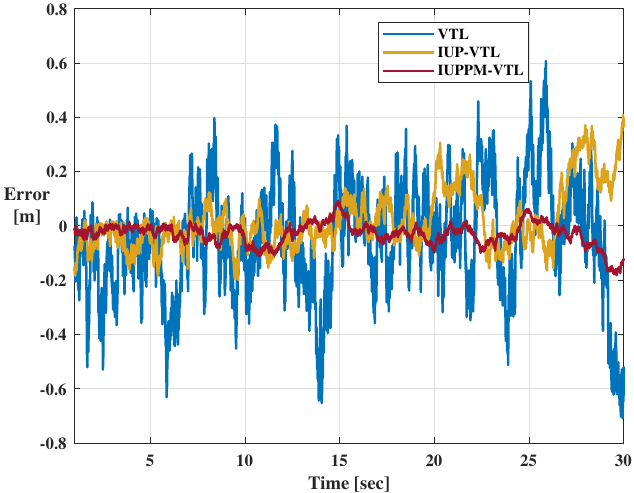
Figure 9. Doppler error of the 10th-Pseudilite.